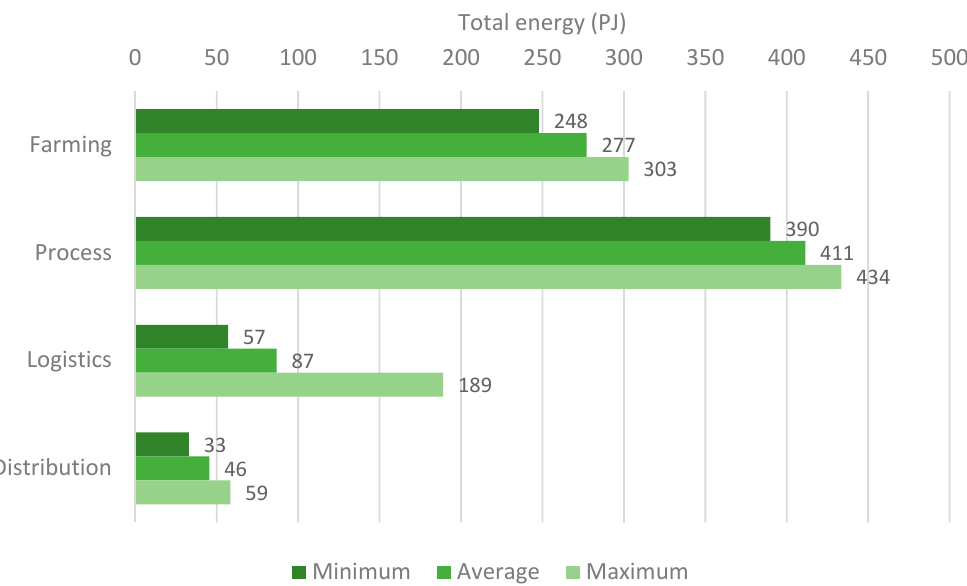
Figure 5. Variations in the total energy inputs of the Italian FSC of year 2011 as a consequence of a variation of the energy intensity parameters, as described in the text.